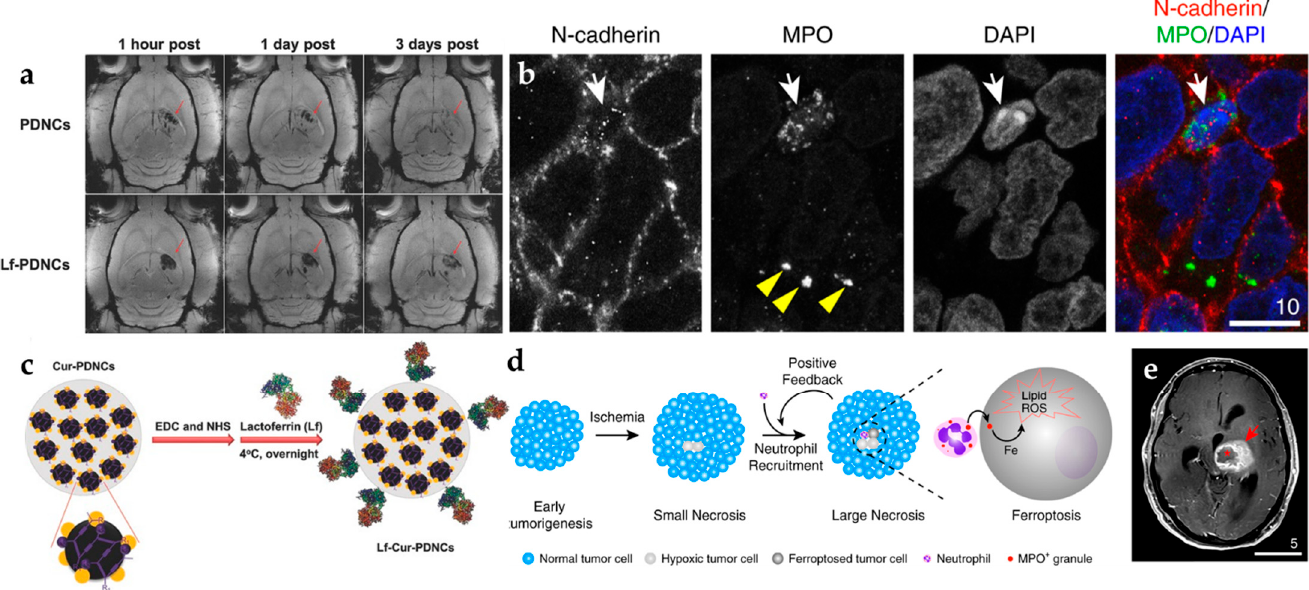
Figure 2. The iron-based nanoprobes in glioblastoma MRI imaging. ( a ) T2-weighted MRI images with contrast accumulation in GBM [25]. ( b ) The confocal images demonstrate that the accumulation of MPO was located in the cytosol (with FITC tracking dye) [26]. ( c ) Modified with lactoferrin on the surface of iron nanoparticles. ( d ) Illustration of neutrophil recruitment crossing with targeted magnetic iron nanoparticles (MPO) and ( e ) in brain tissue GBM MRI imaging. Adapted with permission from Refs. [25,26], Copyright 2016 Wiley and 2020